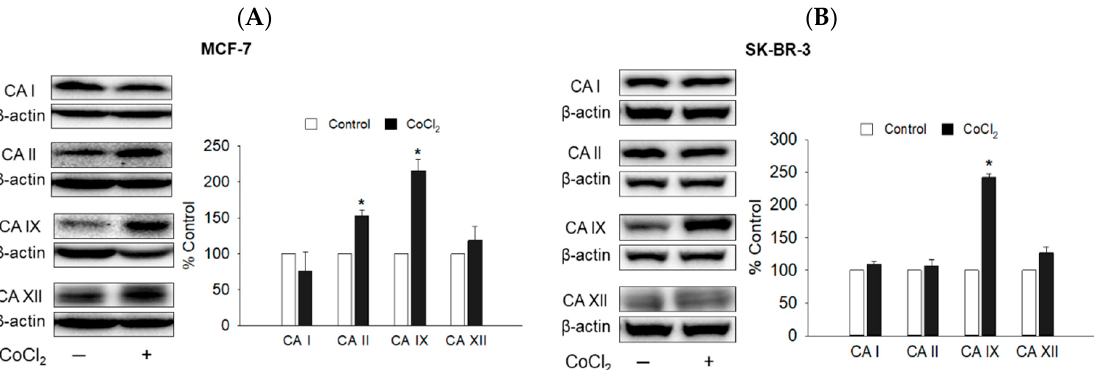
Figure 4. Protein expression of CA I, II, IX, and XII isoforms in MCF-7 and SK-BR-3 cells. ( A ) MCF-7 and ( B ) SK-BR-3 cells were exposed to vehicle or CoCl 2 (100 μ M) for 48 h. Protein levels of CA isoforms were determined by western blotting analyses using anti-CA I, II, IX, and XII antibodies, respectively. β -Actin was used for normalization. The expression level of each isoform in CoCl 2 -treated cells (black bar) is expressed as a percentage of the respective control measured in the vehicle (DMSO)-treated cells without CoCl 2 (white bar). Representative blots are shown. Data are displayed as mean ± SEM from three independent experiments. * p < 0.05 vs. the vehicle-treated control cells.